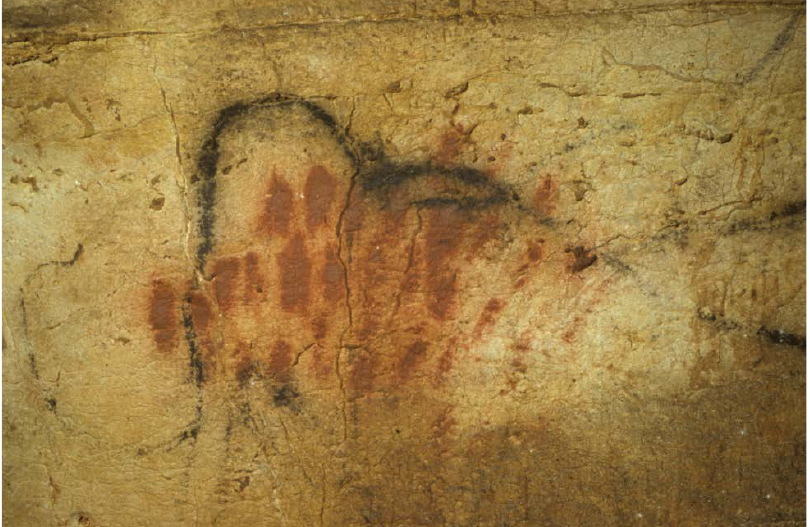
Figure 2. Mammoth detail from Black Frieze of Pech Merle Cave. Photograph by B.